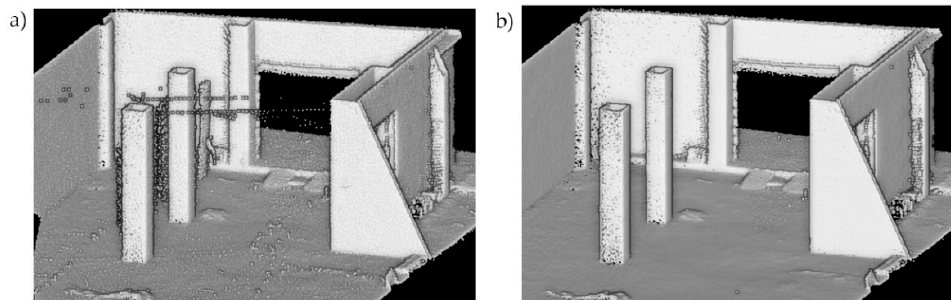
Figure 4. Fast statistical outlier removal (FSOR) filter applied over the point cloud. ( a ) Detail of raw point cloud with noise; ( b ) result after applying FSOR filter.